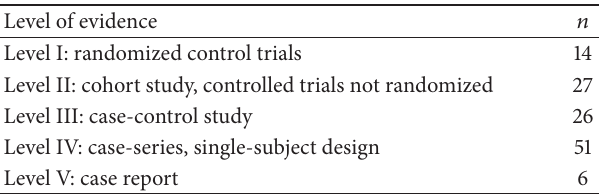
Table 3: Levels of